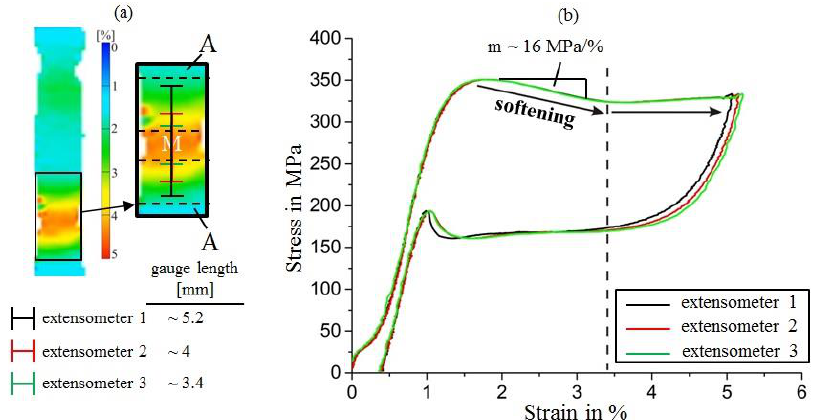
Figure 4. ( a ) Placement of several virtual extensometers in the region where martensite band nucleation first occurs. The strain map clearly shows that (in contrast to the grown band during latter stages of deformation), lower strains occur because the band’s nucleus effectively consists of two meso-scale interfaces that have not yet moved apart; ( b ) Effect of positioning the virtual extensometers in direct proximity to the martensite band on the resulting engineering stress–strain curves during tensile loading. For all virtual extensometers located in the region of the nucleating martensite band, broad nucleation peaks that exhibit pronounced softening are observed. The slope of the softening part of the stress–strain curves, which can be considered as a very broad nucleation peak, is approximately 16 MPa/%, which is substantially different to the nearly constant stress level typically observed in the nominal stress–strain curves of pseudoelastic NiTi. This corresponds to a stress-drop of about 50 MPa over a strain range of about 3%, as shown in Figure 4b. These values may inform future modeling studies that aim at capturing localization phenomena in NiTi.